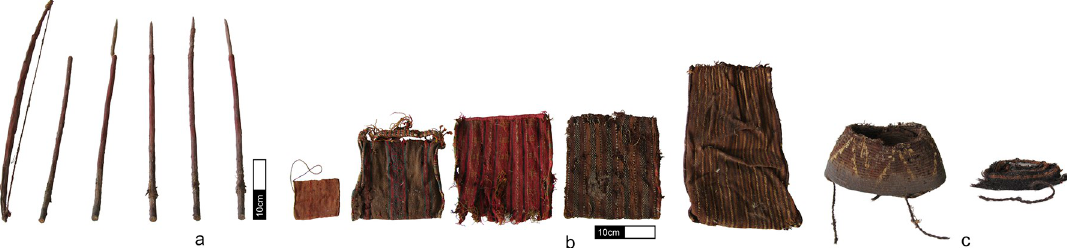
Fig 4. Main objects associated with the excavated Tomb No. 1, Caleta Vitor Bay 2. (a) bow and arrows; (b) chuspas and talega ; (c) hats (photograph by Jacqueline